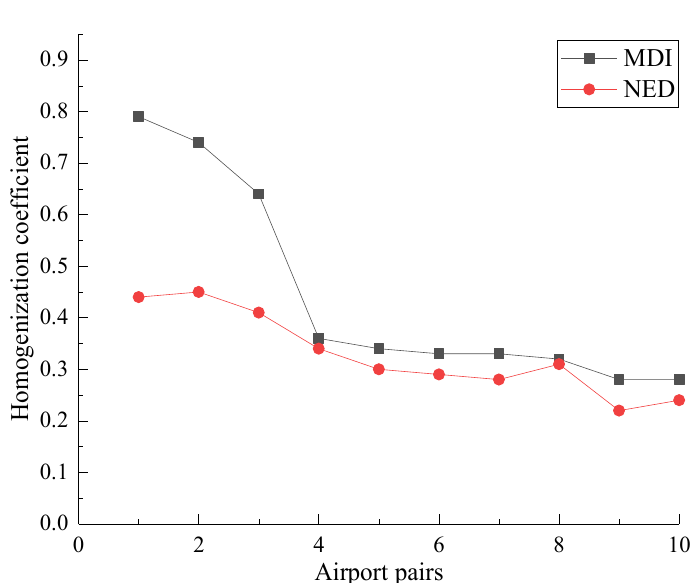
Figure 13. MDI and NED results of the London MAR.